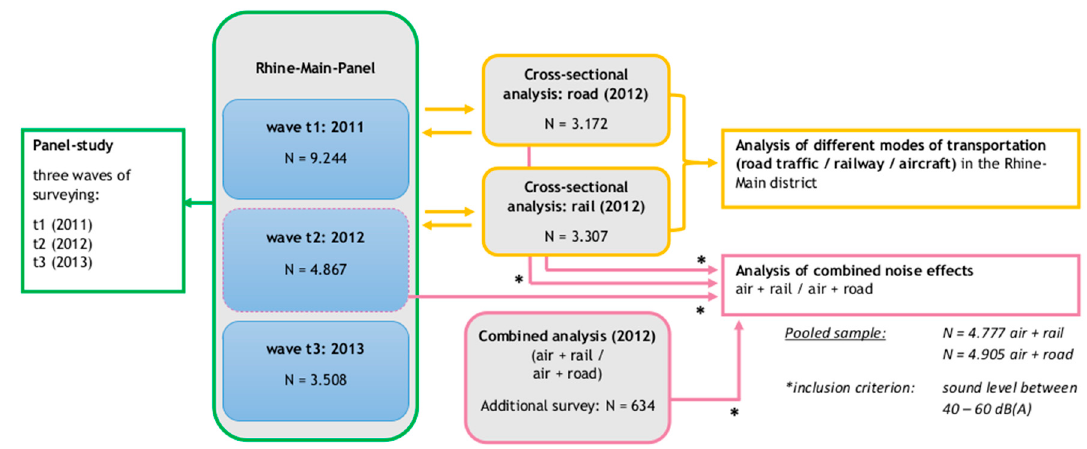
Figure 1. Flow chart of the sample data included in the study. (* = All data included from this sample had an average sound pressure level within the range of 40 to 60 dB(A)).